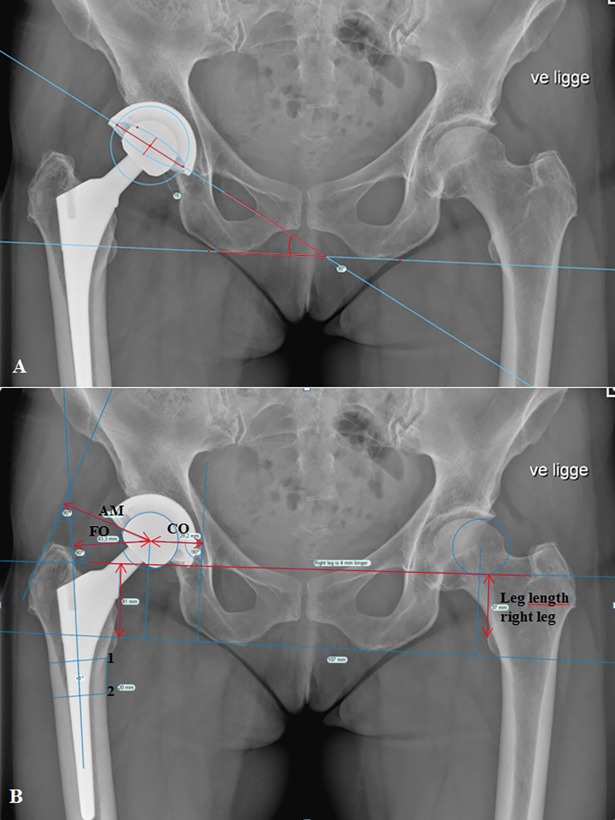
Example of measurements in TraumaCad®.(A) Anteversion and inclination on postoperative anterior-posterior radiographs of the pelvis. (B) Center of rotation (COR) marked on the operated side. The femoral shaft line was drawn from the center of two parallel lines with the shortest length across the femur extracted from two points marked at the distal level of the lesser trochanter and 20 mm distal from the lesser trochanter.